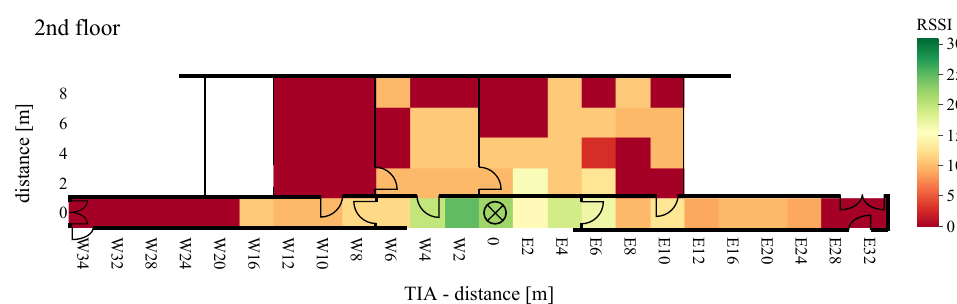
Figure 25. RSSI of TIA board with WuRx and WuTx on different floors.